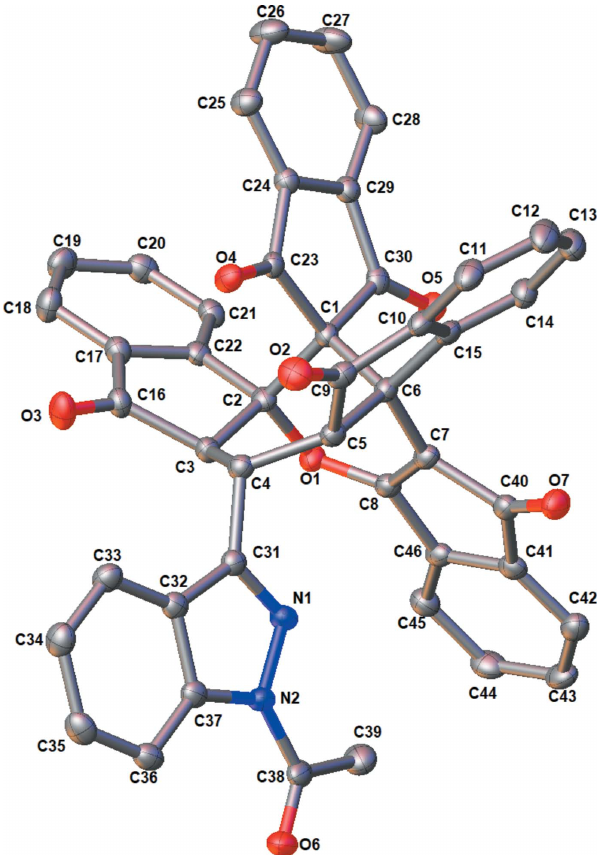
Figure 3 ( a ) The central eight-membered ring of the compound with the bridging carbon atom between C2 and C6. ( b )–( f ) The various arms extending from the central ring, showing the connection to the central